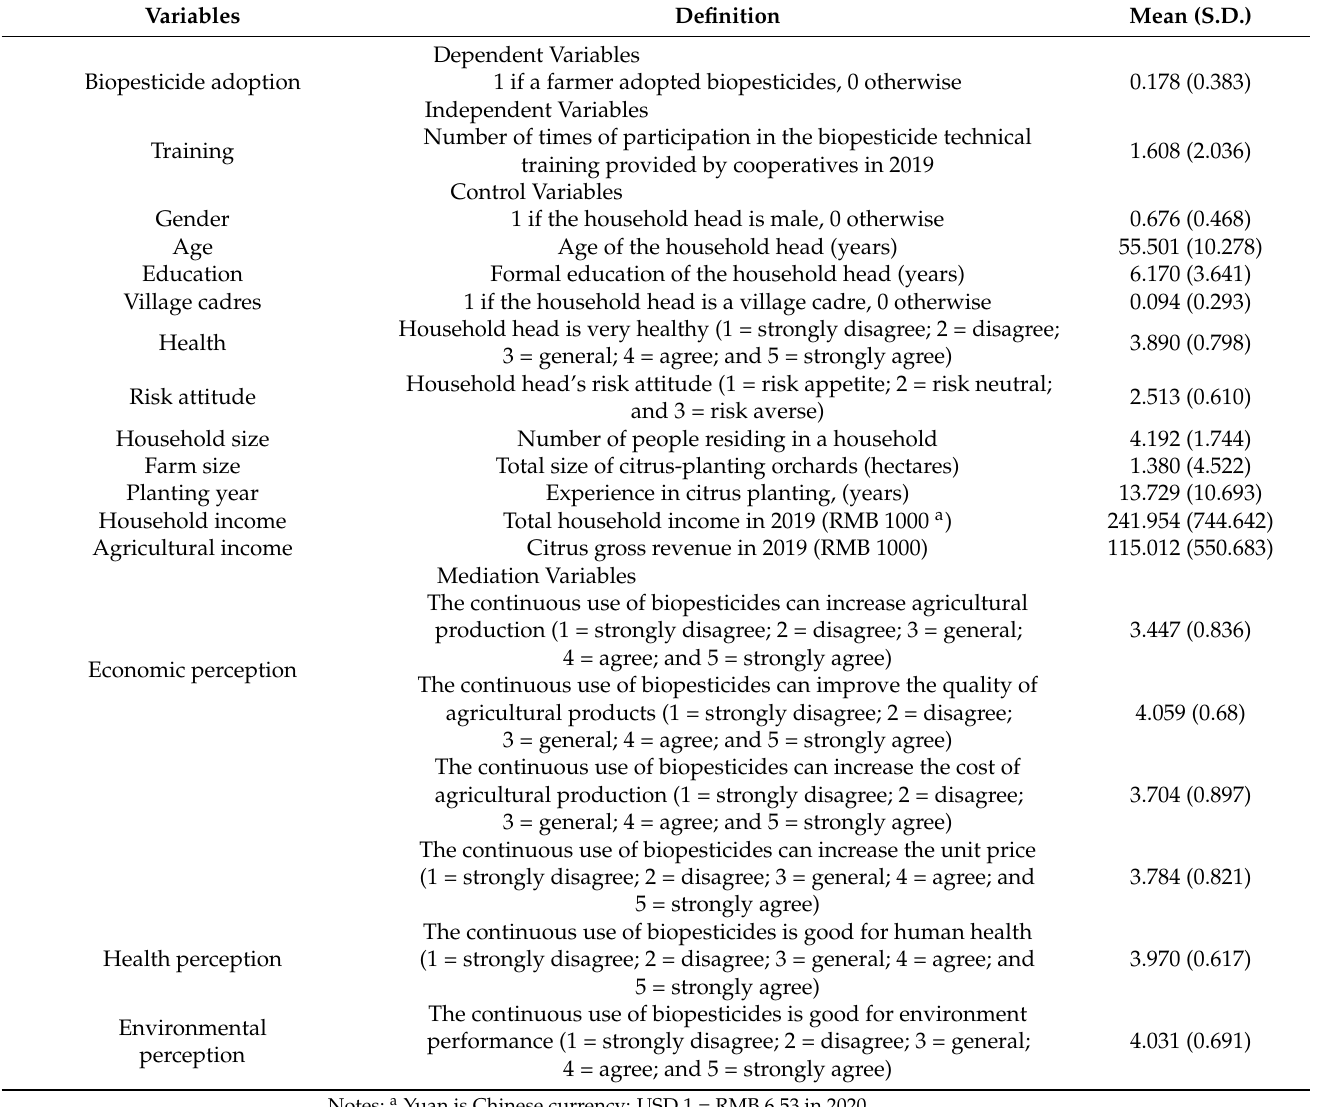
Table 1. Definition of variables and descriptive